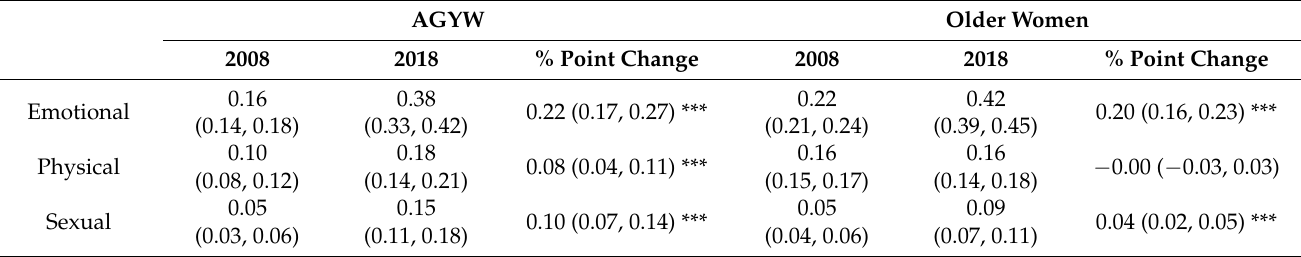
Table 2. Changes in Proportions of Reporting IPV in the Past 12 Months among Ever-partnered Female Respondents who Completed the Domestic Violence Module by Age Group (proportion (95%